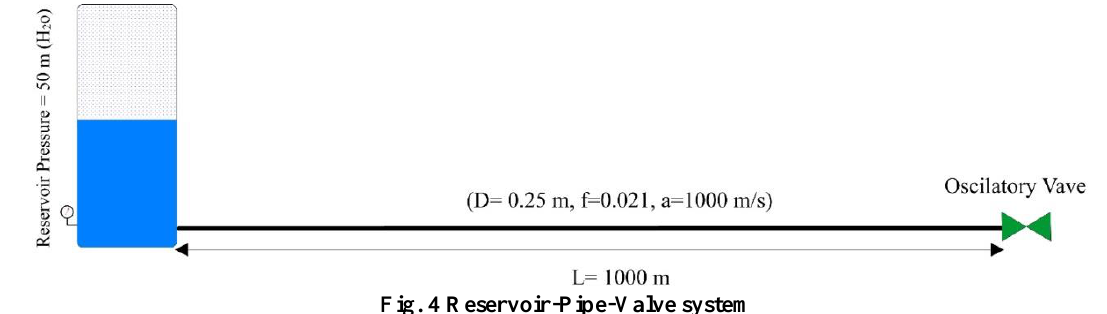
Fig. 4 Reservoir-Pipe-Valve system